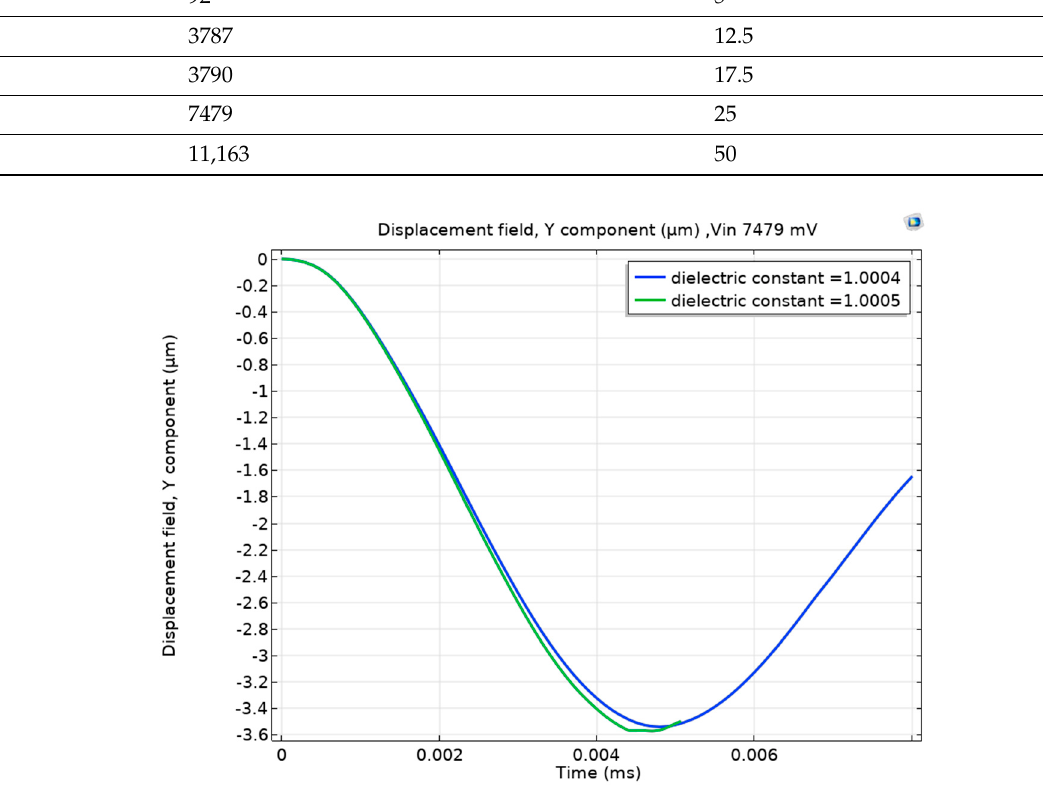
Figure 7. Helium detection at 3.78 MHz; it is noticeable that the detection level increased to 25%, degrading the sensor’s performance. Table 2. The e ff ect of excitation frequency on helium detection level and input voltage.